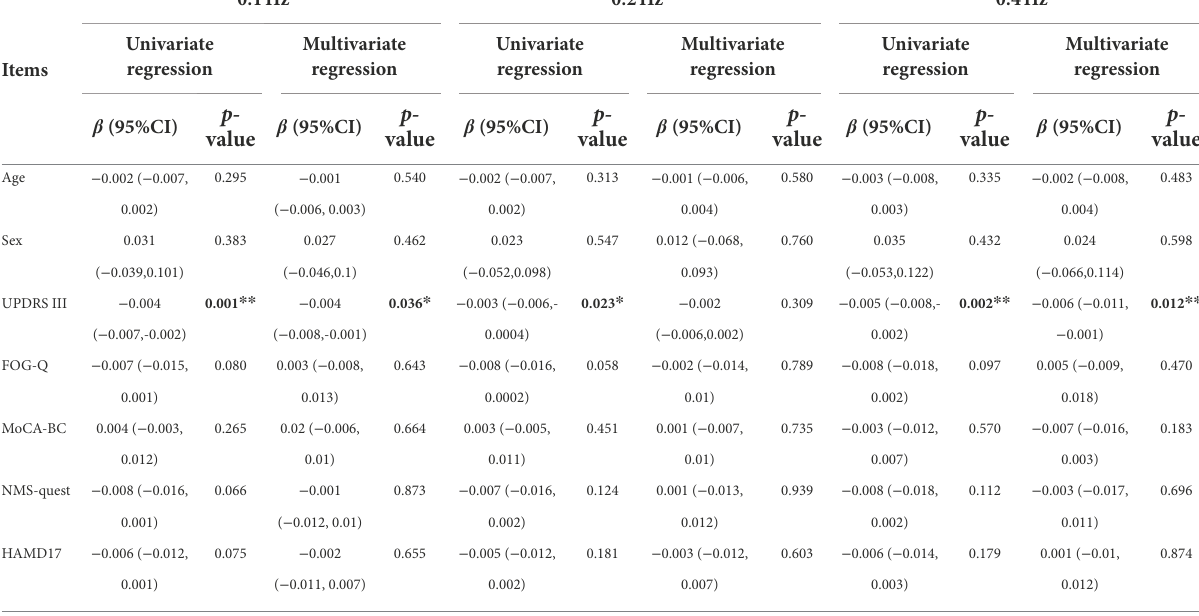
TABLE 4 Independent associated factors of smooth pursuit gain in de novo PD patients.